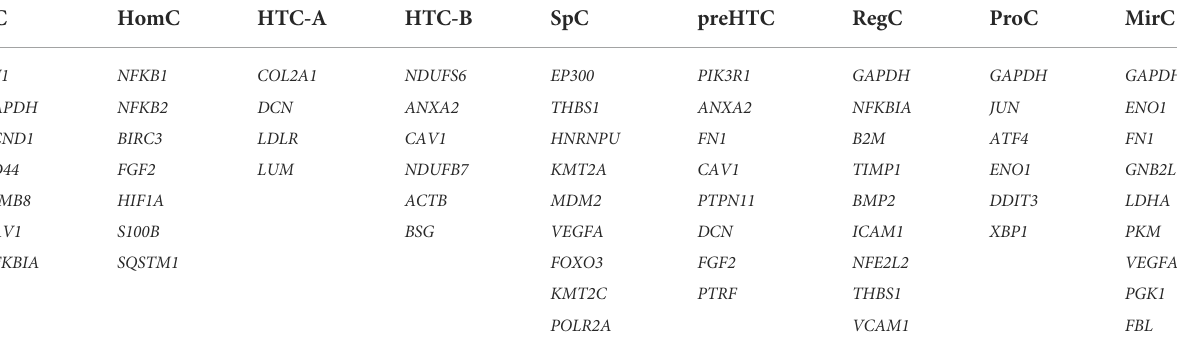
TABLE 2 Summarized hub genes for each cell